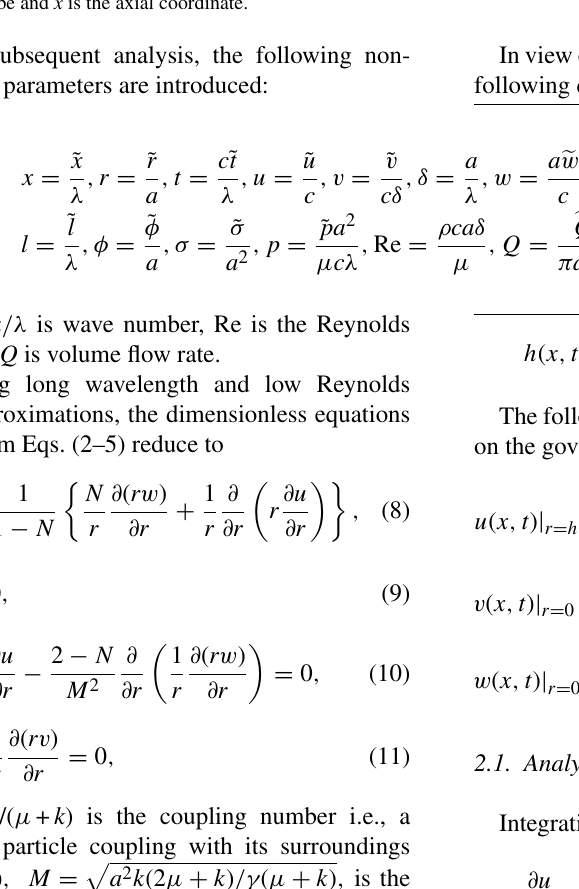
Fig. 1. The diagram, based on Eq. (12), represents the propagation of a progressive wave along the walls of the tube containing fluid, which undergoes contraction and relaxation but no expansion beyond the boundary. h is the radial displacement of the wall, c is the wave velocity, l is the length of tube and x is the axial